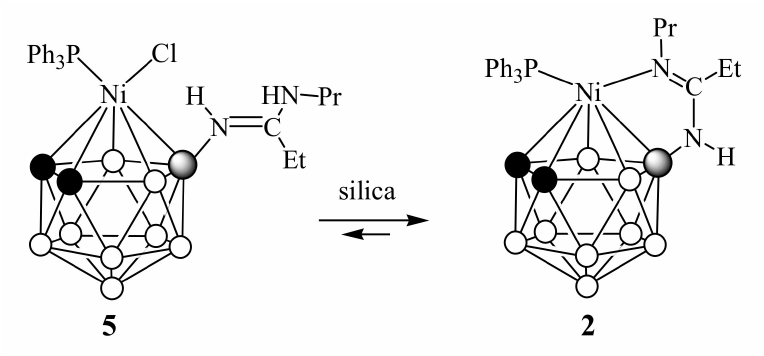
Scheme 2. Behavior of complex 5 during purification on column chromatography with silica